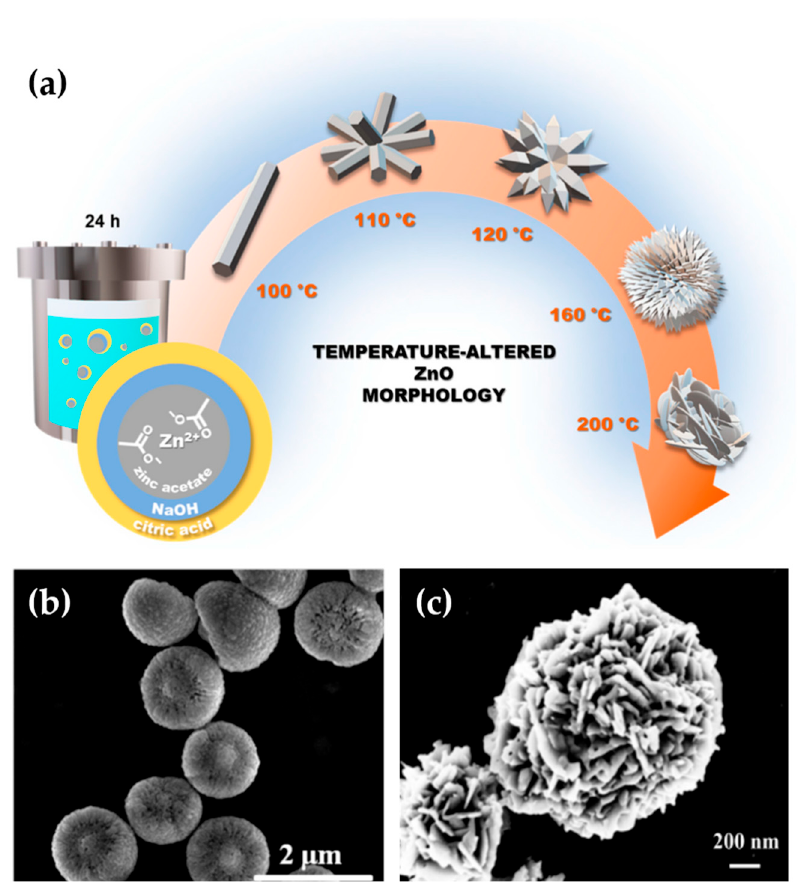
Figure 2. ( a ) Hydrothermal equipment for manufacturing various ZnO superstructures at di ff erent temperatures. This was reprinted with permission from [48] and copyright belonging to 2023